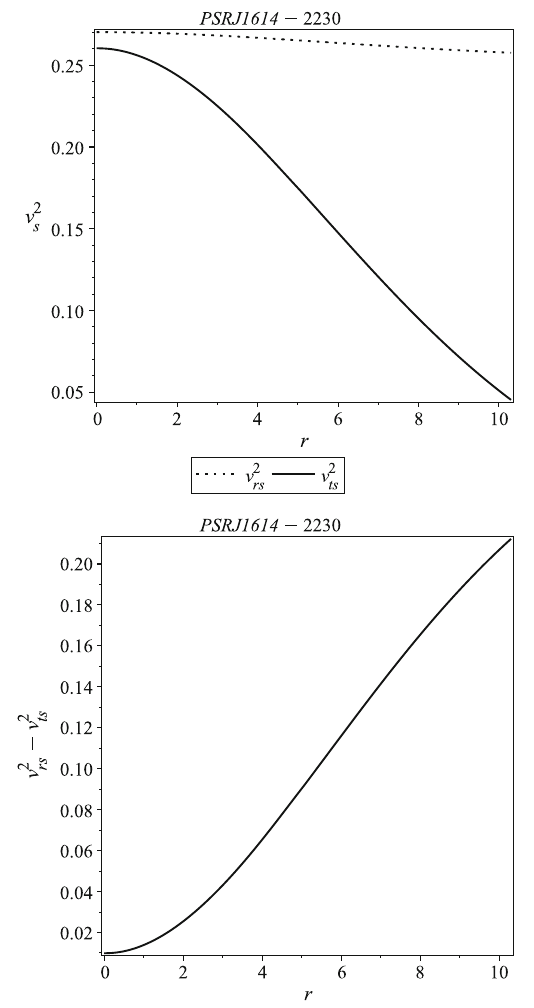
(cid:12) (cid:13) 32 B g ( a 2 + 2 b )π + 3 B 2 a + 4 bB χ 2 + ( 64 π aB + 3 B 2 + 7 Ba g g